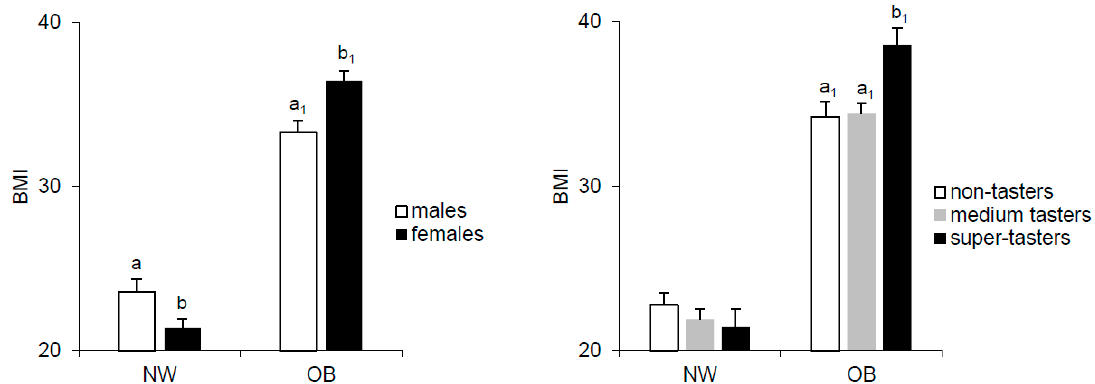
Figure 1. Mean values (± SEM) of body mass index (BMI) in normal weight (NW) ( n = 61) and obesity (OB) ( n = 57) according to gender (NW: male n = 21; female n = 40. OB: male n = 23; female n = 34) and to PROP taster status (NW: NT n = 22; MT n = 29; ST n = 10. OB: NT n = 14; MT n = 32; ST n = 11). a,b = significant difference within NW; a 1 ,b 1 = significant difference within OB ( p ≤ 0.017; Fisher’s least significant difference (LSD) test.